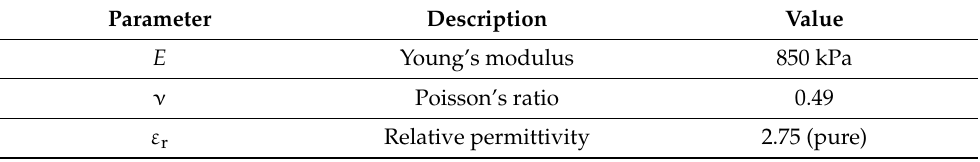
Table A1. Material parameters of